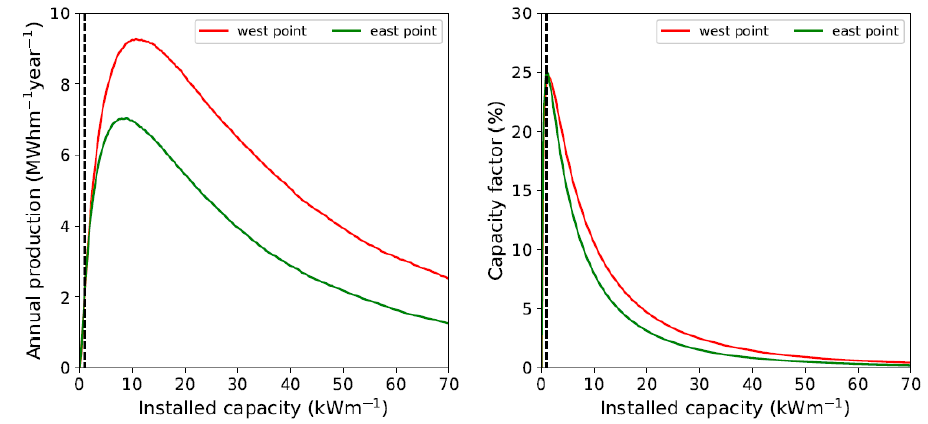
Figure 10. Predicted mean ( left ) annual energy production and ( right ) capacity factor against the installed capacity at the two locations considered at the western and eastern ends of the line offshore from the harbour breakwater and during the ten-year period from 2006 to 2015. The vertical black line shows the position of peak capacity factor reached for an installed capacity around 1.0/1.25 kW m − 1 .